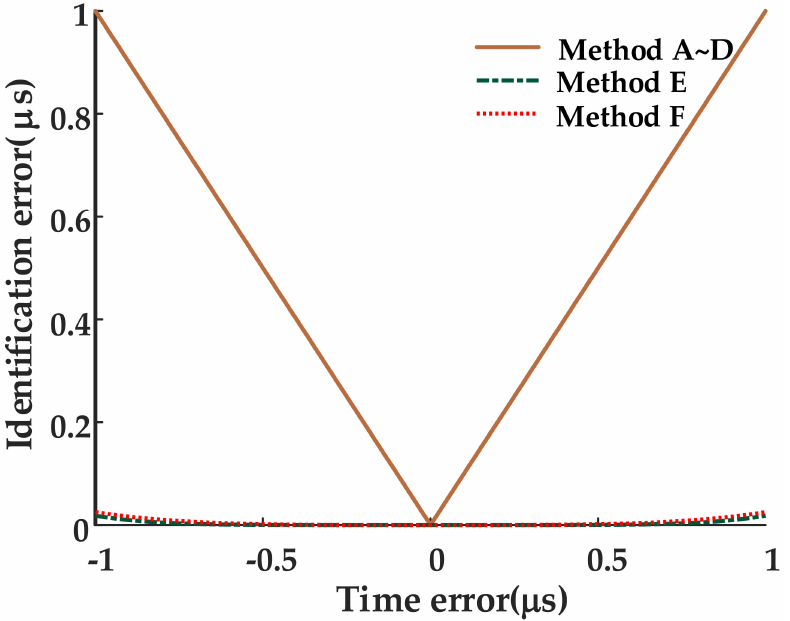
Figure 13. The performances of methods A–F with a recording time error added to I a 1 . (The ordinate axis represents the absolute value of the identification